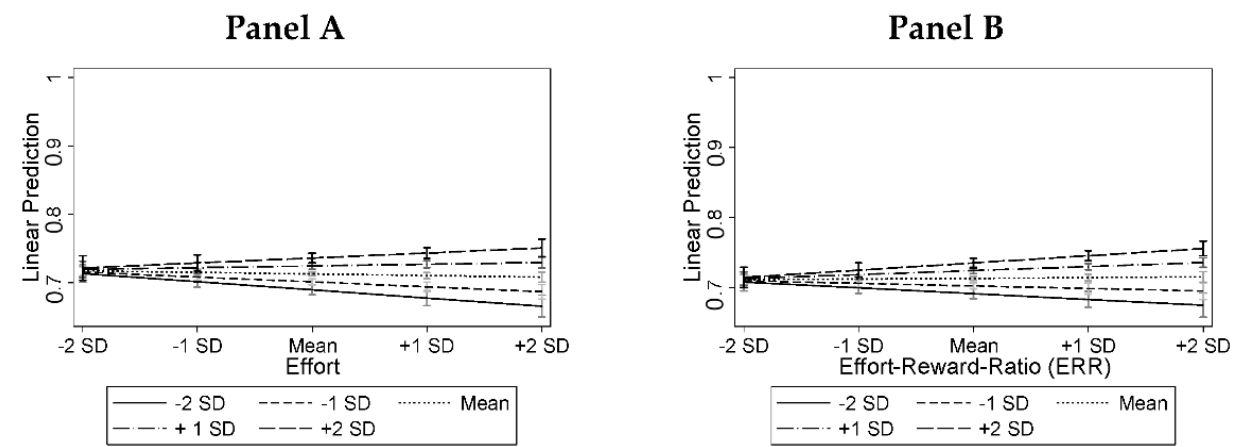
Figure 2. Predictive margins with 95% CIs for the 12-month CE-drug misuse frequency measured at t 2 depending on effort ( Panel A , based on model 3), the effort–reward-ratio (ERR, Panel B , Based on Model 4), and the conditioning role of overcommitment, which is indicated by the different plotted lines with varying ascent (all measured at t 1 ). Notes: Results are plotted for different combinations of values (i.e., from minus two standard deviations to plus two standard deviations) of effort, ERR, and overcommitment.